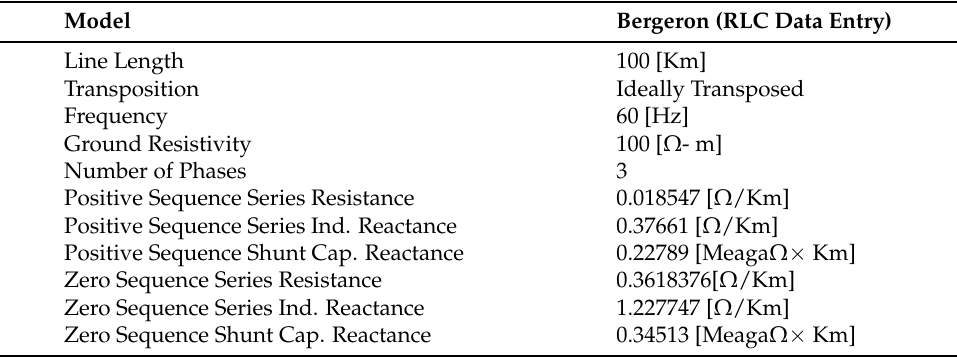
Table 3. Transmission line Bergeron model